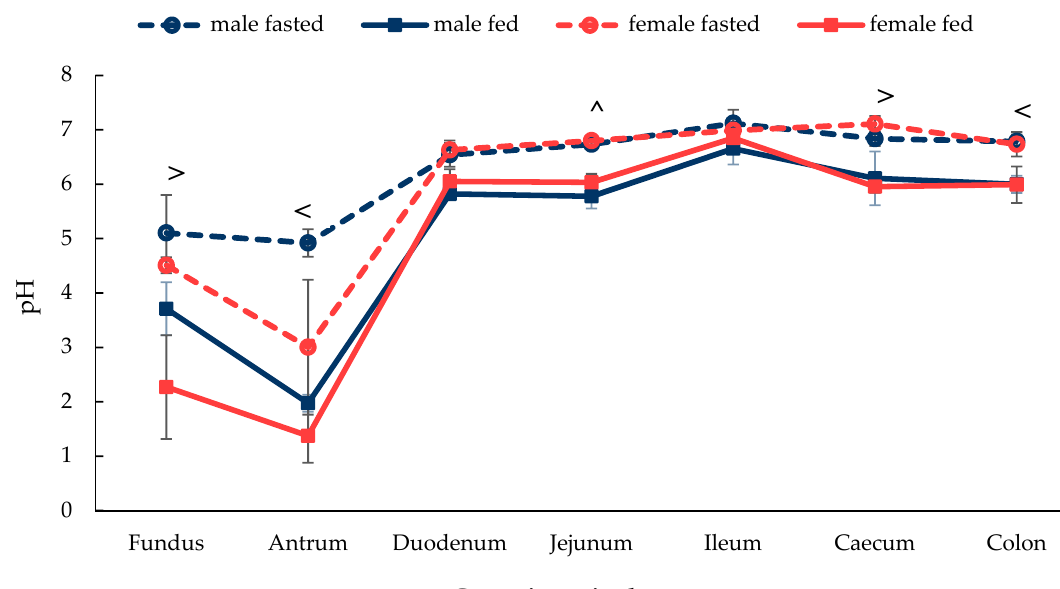
Figure 1. pH change in the luminal environment along the GI tract in male and female in the fasted state and fed state rats measured in situ. (Mean ± SD, n = 6). The following symbols (i) < denotes a statistical significance ( p < 0.05) between fasted and fed state in male rats, (ii) > denotes a statistical significance ( p < 0.05) between fasted and fed state in female rats and (iii) ˆ denotes a statistical significance ( p < 0.05) between fasted and fed state in both male and female rats.